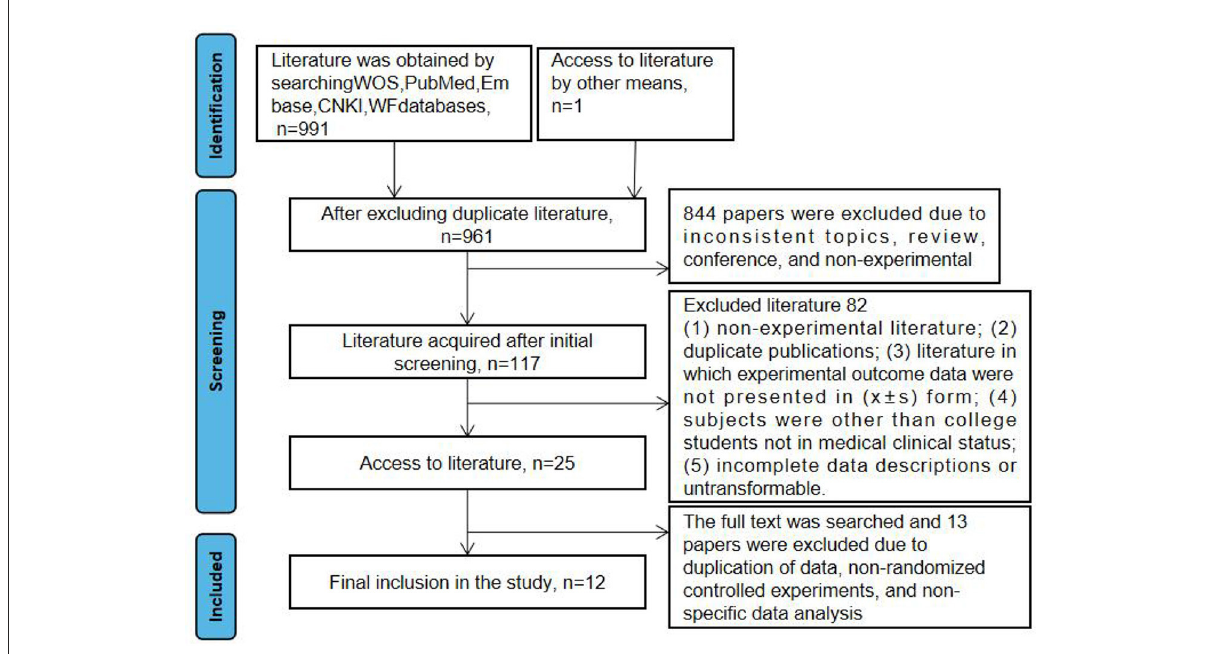
FIGURE1 PRISMA selection process